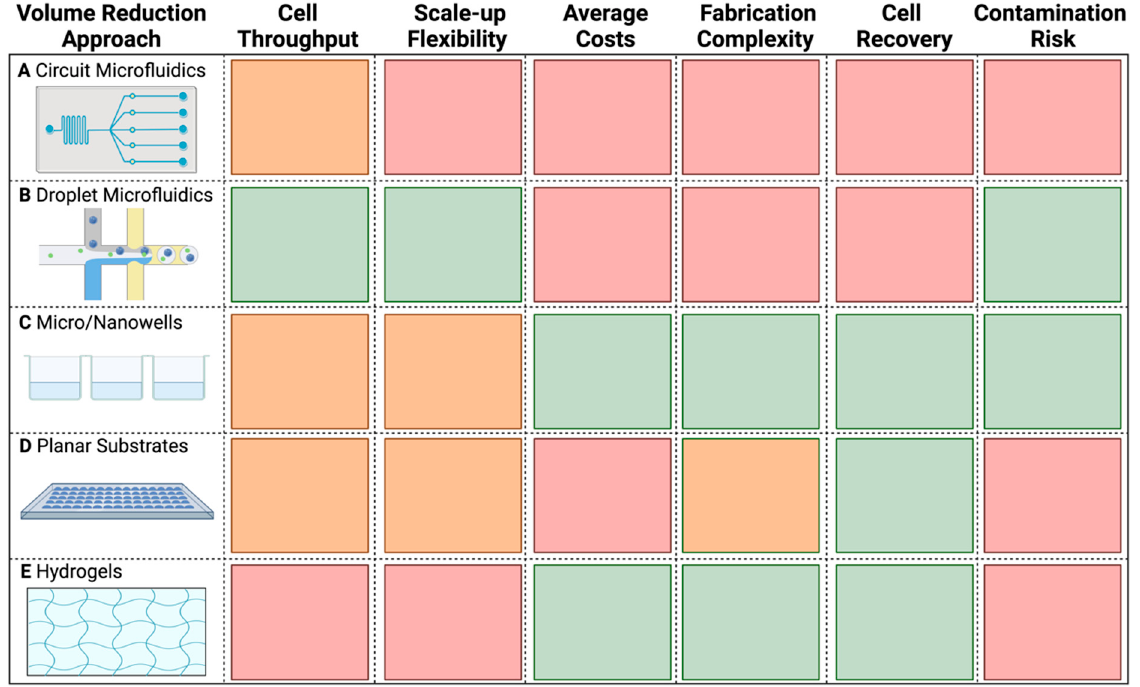
Figure 2. Characteristic comparison of the different microbial SCG volume reduction methods. ( A ) Circuit microfluidics. ( B ) Droplet microfluidics. ( C ) Micro/Nanowells. ( D ) Planar substrates. ( E ) Hydrogels. The color code indicates the relative advantage of a particular approach based on a given feature, from green (better advantage), through orange, to red (less advantage). Table was generated with information from Zhou et al., Fung et al., and Nguyen et al. [54,55,57], as well as from our own experiences with droplet microfluidics, microwells, and planar substrates. Made with Biorender.com.